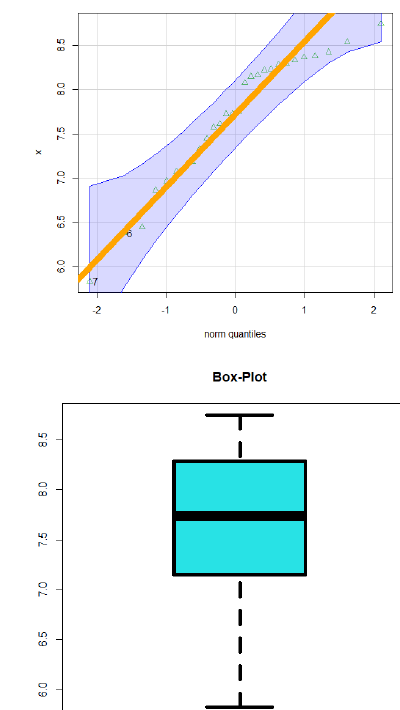
Figure 8. The initial scattergram ( left graph ), the fitted scattergram ( middle graph ), and smoothed scattergram ( right graph ).